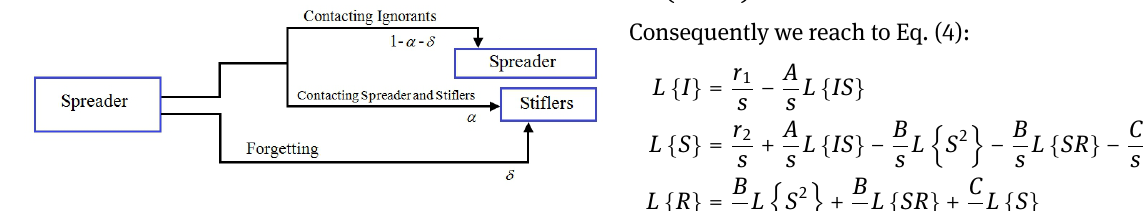
Fig. 1. Schematic of rumor spreading procedure